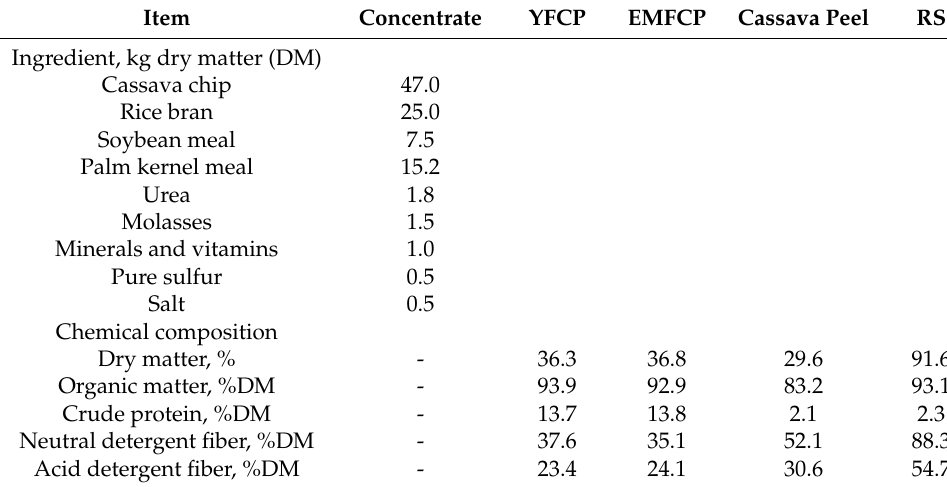
Table 1. Ingredients and chemical compositions of the experimental diets.